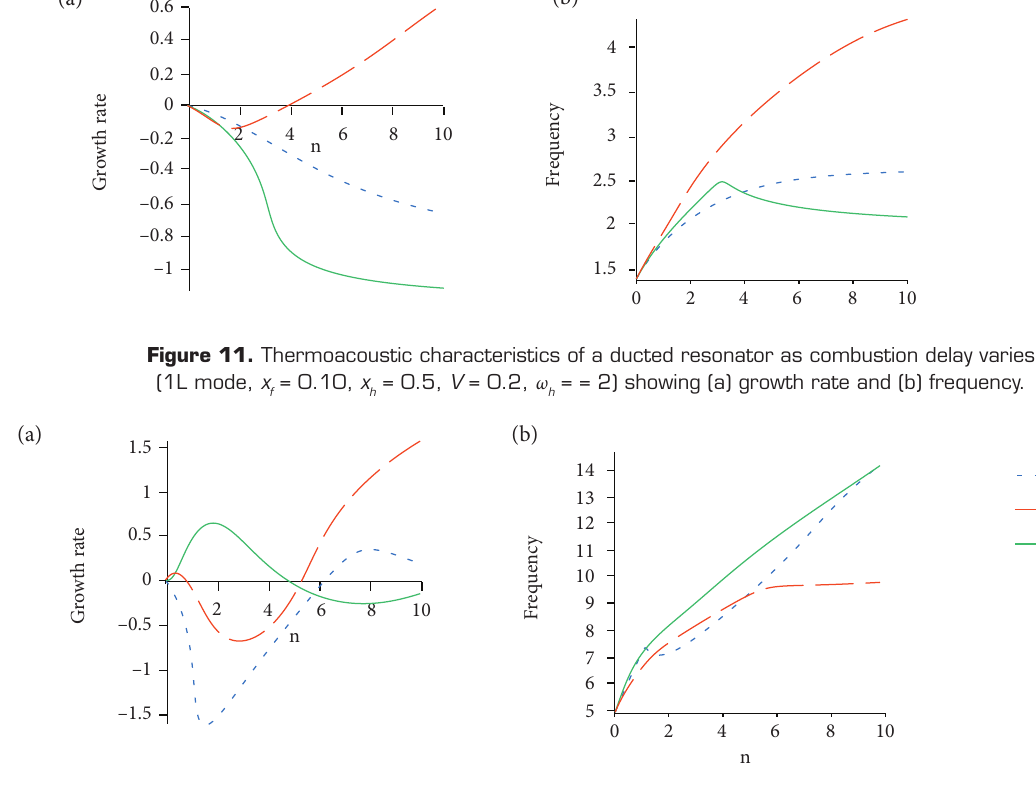
Figure 12. Thermoacoustic characteristics of a ducted resonator as combustion delay varies